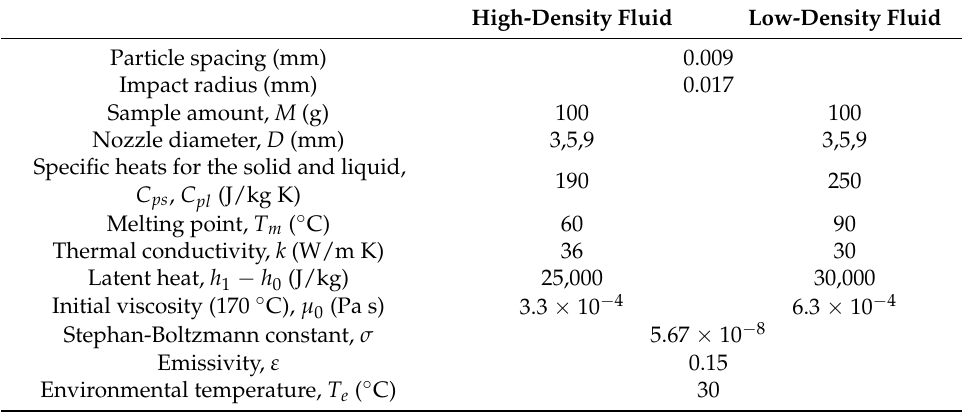
Figure 9. Simulation geometry with the different stratification conditions. Table 4. Calculation conditions for the simulation.